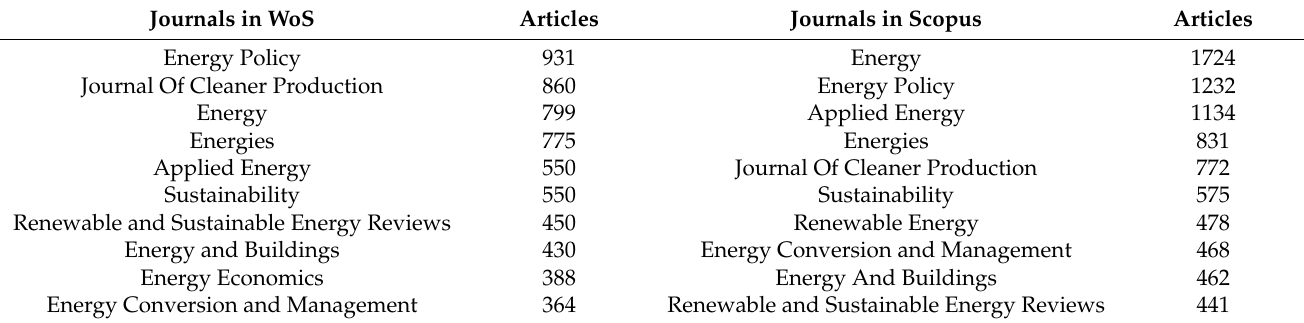
Figure 6. Number of articles published annually using second query. Source: Own elaboration. Table 2. Top 10 Journals in Web of Science and Scopus for first query.